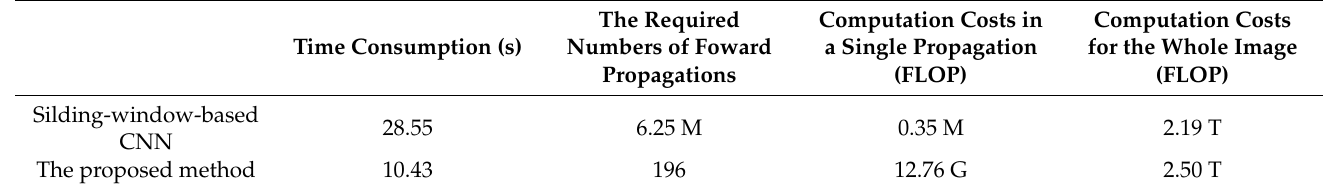
Table 1. The time consumptions and computation costs for inferencing a 2500 × 2500 PolSAR